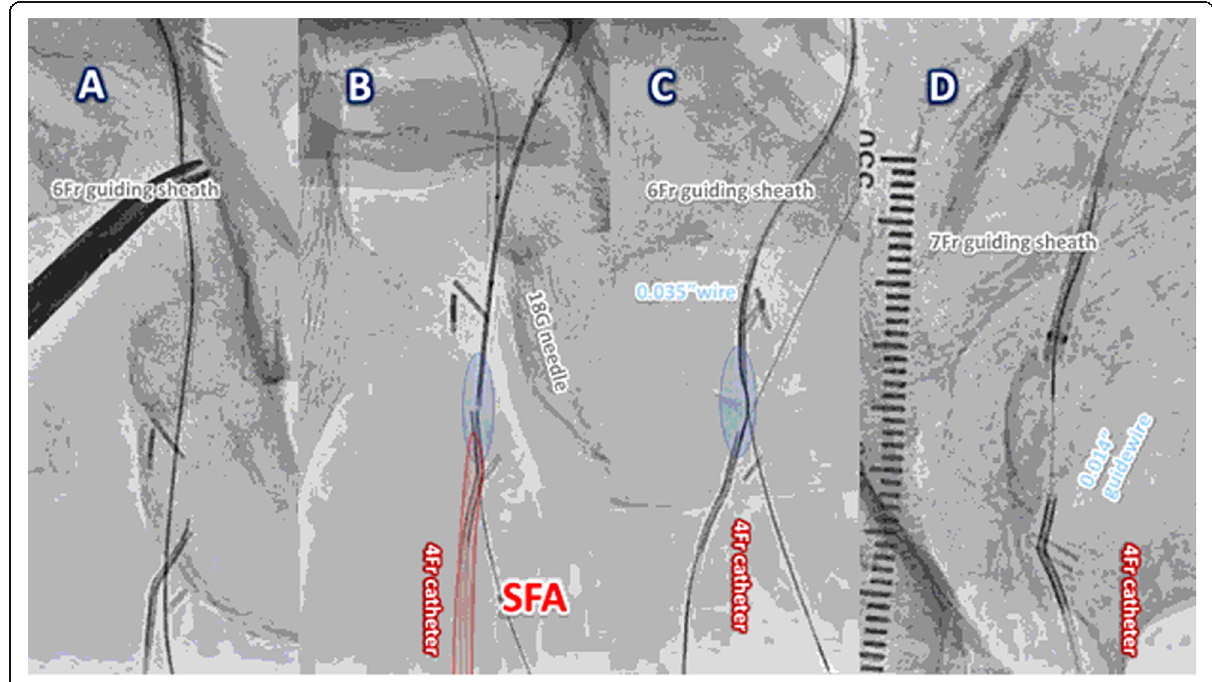
Fig. 2 The treatment process of Needle Bypass technique. A . An antegrade 6-Fr guiding sheath was inserted over the pull-through guidewire into the body between the puncture sites. B . The third 18-gauge needle punctured from the proximal site through the space (blue frame), which was formed by a 4.0 × 20-mm semicompliant balloon dilatation, into the SFA lumen where a retrograde 4-Fr catheter was inserted. C . After the guidewire externalization with 0.014-in. guidewire between the third needle and 4-Fr catheter, the 4-Fr catheter was advanced into the space (blue frame) on a 0.035-in. guidewire and together advanced into the antegrade 6-Fr guiding sheath. D . After removal of the 6-Fr guiding sheath, a 0.014-in. guidewire inside the 4-Fr catheter was advanced into an antegrade 7-Fr guiding sheath from the left CFA as a contralateral